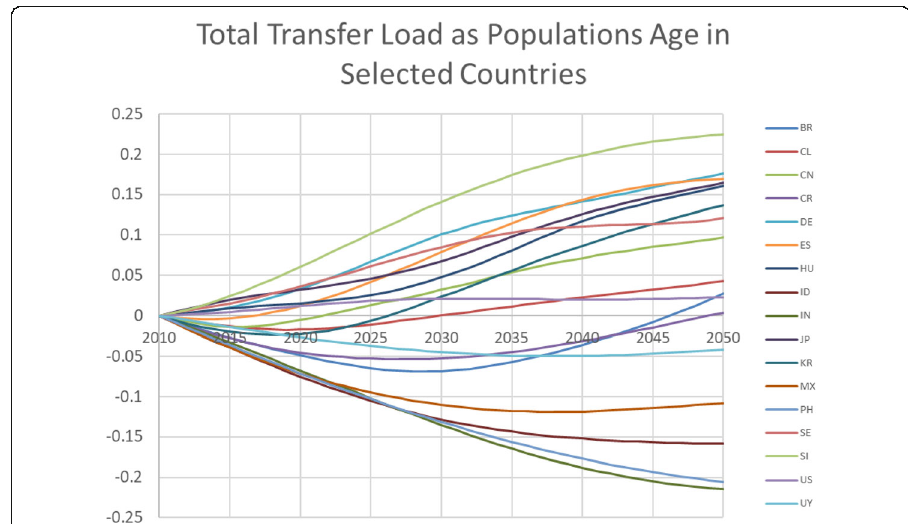
Fig. 11 Change in total transfer load as populations age in selected countries. Note: Total transfer load is the projected increase in public transfer budget deficit plus private transfer deficit assuming base period public and private age profiles are fixed and the population age distribution varies as projected by the United Nations Population Division (2013). Load is expressed as a proportion of projected aggregate consumption assuming the age profile of consumption is also fixed at base period. Source: Calculated